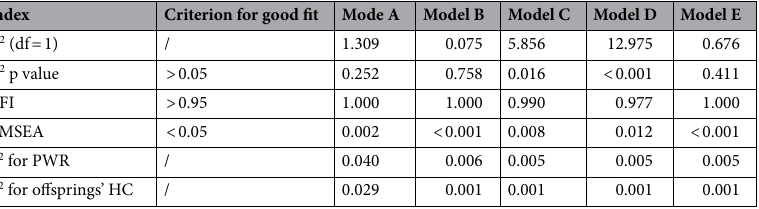
Table 5. Model Fit Summary for the Final Path Analysis. Each model is assigned for the Fig. 2 panel with same letter (e.g. Model A is assigned for Fig. 2A). CFI comparative fit index, HC head circumference, PWR placental weight ratio, RMSEA root mean square error of